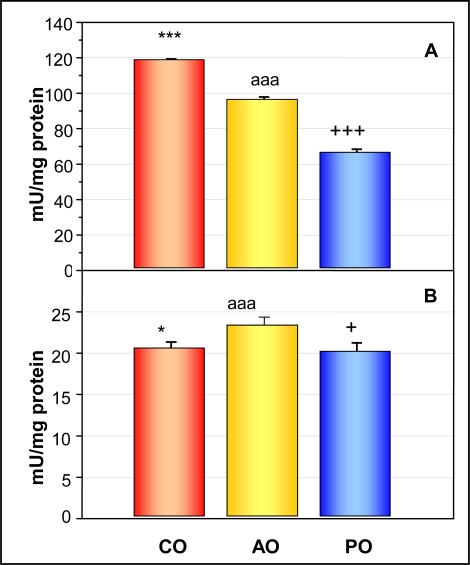
Offspring hepatic glutathione peroxidase (A) and serum glutathione peroxidase (B) activities (mU/mg protein). Signification: CO vs AO *p < 0.05, ***p < 0.001; AO vs PO aaap < 0.001; CO vs PO +p < 0.05, +++p < 0.001.